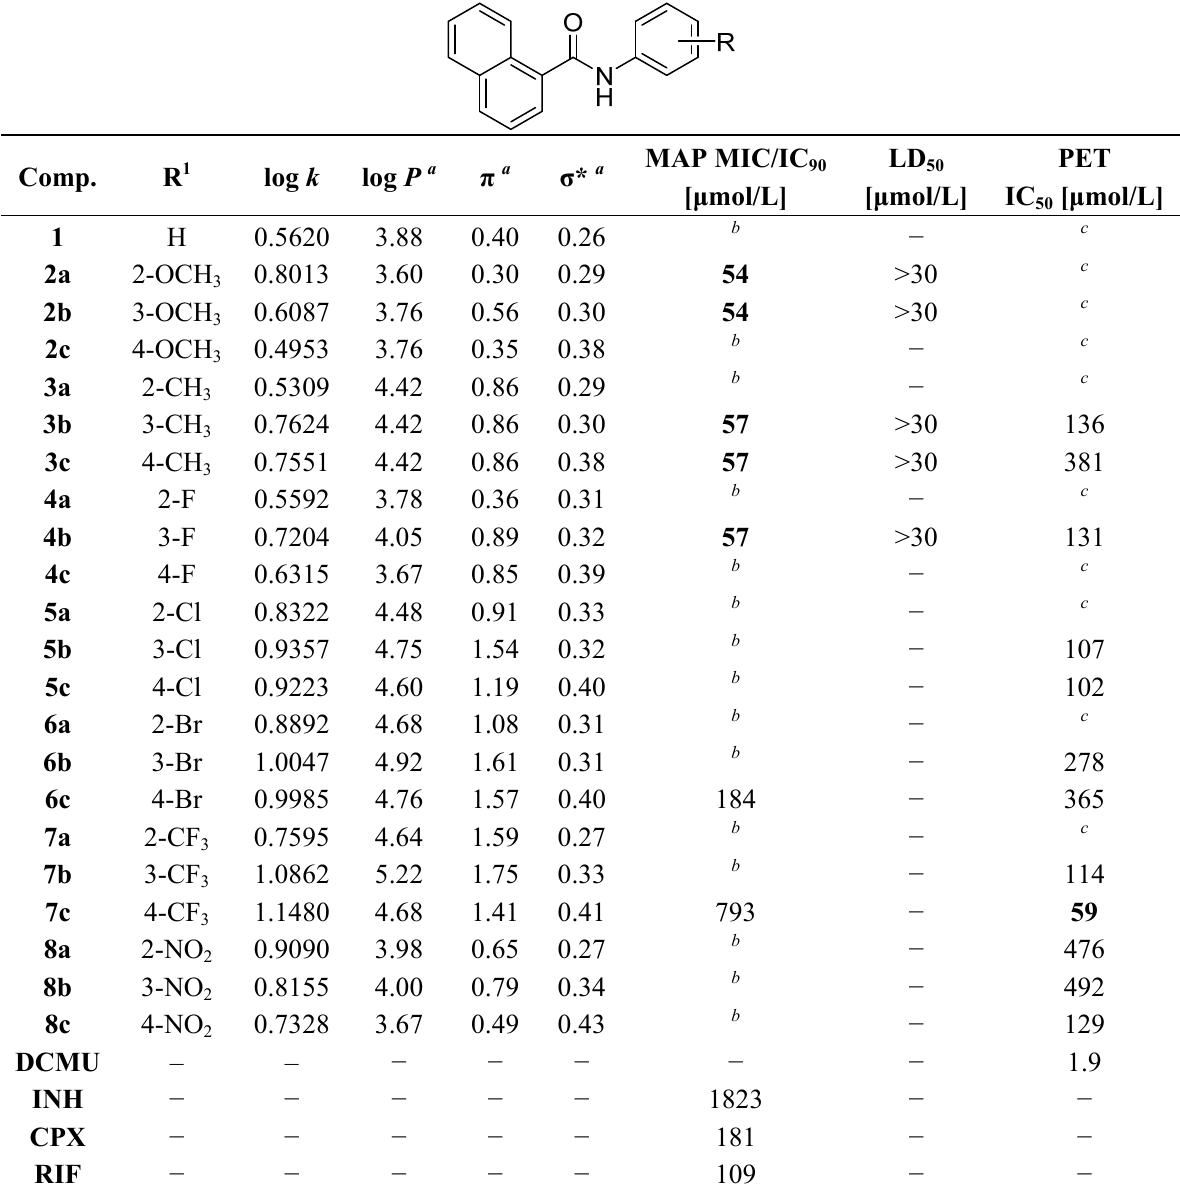
Table 1. Structure of ring-substituted naphthalene-1-carboxanilides 1 – 8c , experimentally determined values of lipophilicity log k , calculated values of lipophilicity (log P ), predicted hydrophobic distributive parameter π , predicted polar substituent constants σ *, in vitro antimycobacterial activity (MIC/IC ) of compounds against clinical isolate of 90 Mycobacterium avium subsp. paratuberculosis CIT03 (MAP) in comparison with isoniazid (INH), ciprofloxacin (CPX), and rifampicin (RIF) standards, in vitro cytotoxicity assay ) of choice compounds and IC values related to PET inhibition in isolated spinach (LD 50 50 chloroplasts in comparison with 3-(3,4-dichlorophenyl)-1,1-dimethylurea (DCMU) standard.